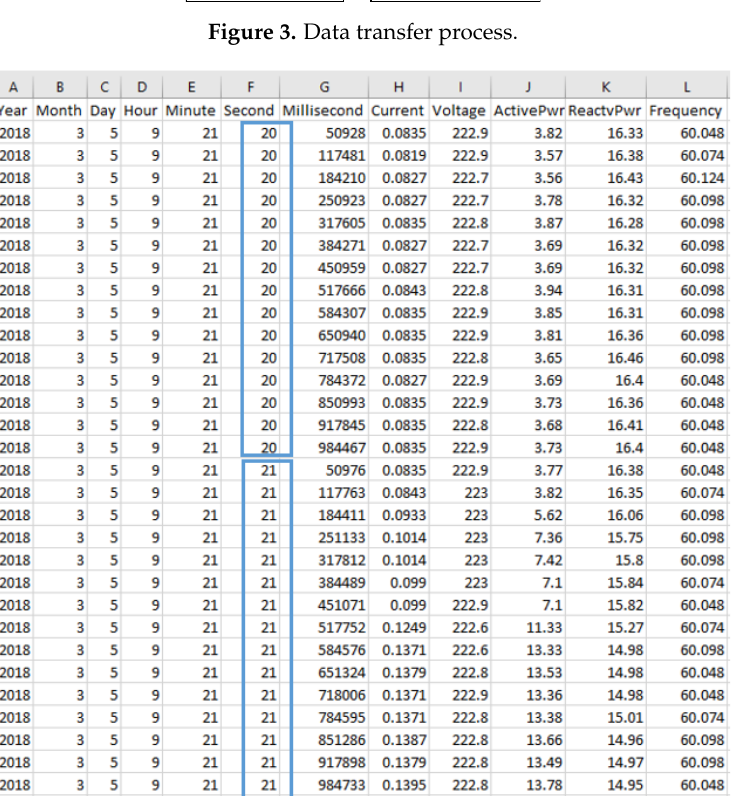
Figure 4. The low sampling rate format data collected in 15 Hz of Air-purifier